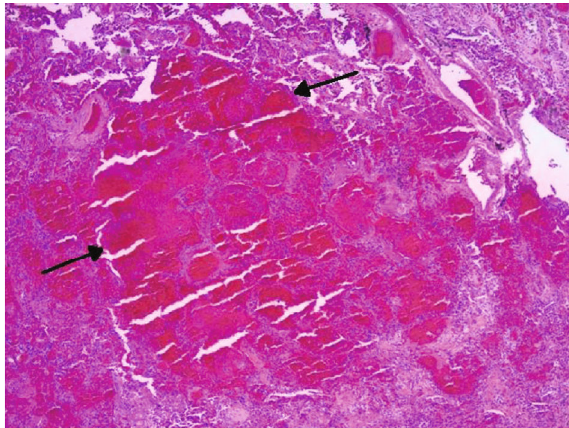
Figure 5: 4x magni fi cation — acute hemorrhagic infarction of lung parenchyma (arrows).